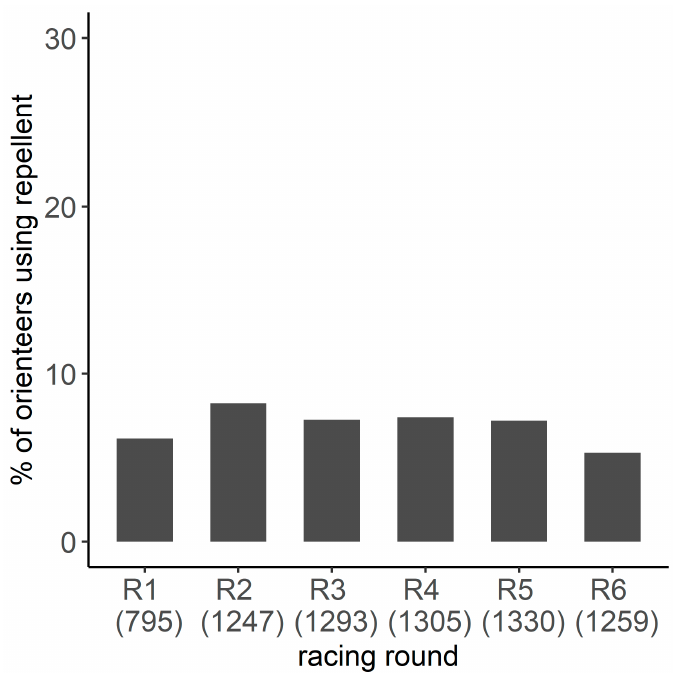
Figure A1. Frequency of tick bites per racing round. ( A ) Minimal proportion of orienteers bitten by ticks per racing round and its 95% confidence interval, estimated by the number of orienteers reporting tick ‐ bites on the banner and by submit ‐ ting ticks divided by the number of orienteers running the competition. Exposure index of the minimal number of orient ‐ eers bitten by ticks among 100 orienteers walking ( B ) one kilometer or for one hour ( C ). The number in parentheses rep ‐ resents the number of orienteers running the racing round.